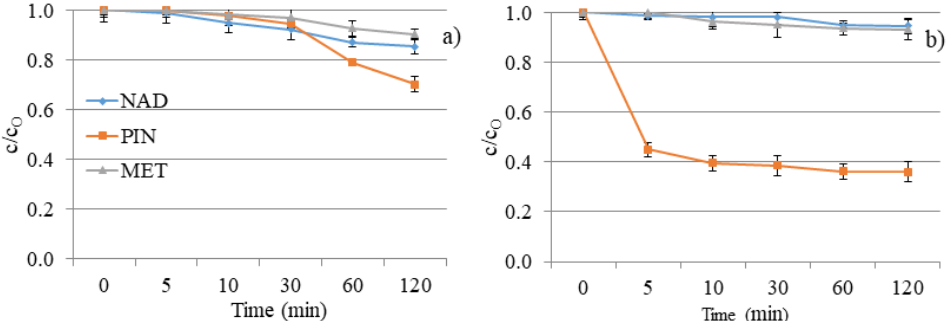
Figure 9. NAD, PIN, and MET degradation kinetics under UV irradiation: ( a ) without V 2 O 5 and ( b ) with V 2 O 5 catalyst.